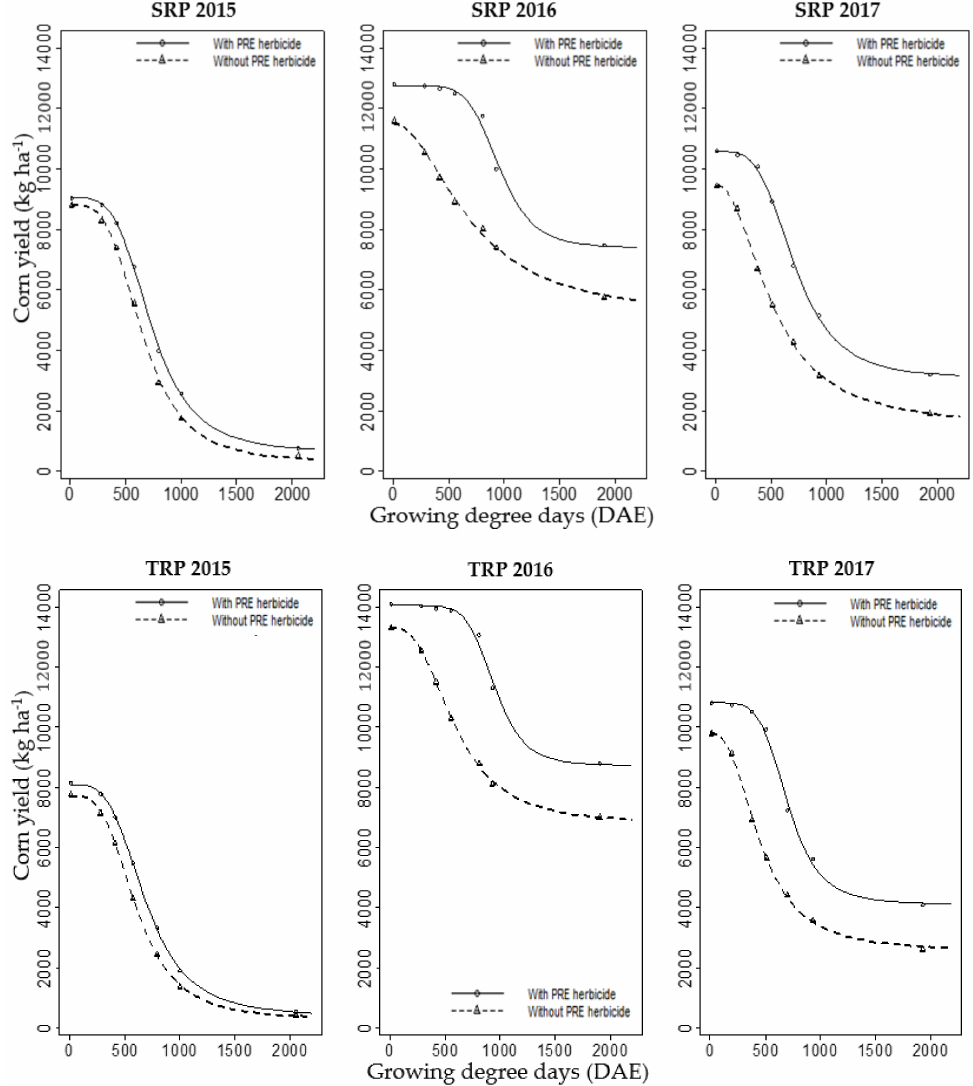
Figure 2. Crop yield (kg ha − 1 ) response to increasing duration of weed interference as represented by growing degree days (days after emergence, DAE) in corn grown without pre-emergence (PRE) herbicide and with PRE herbicide treatments in Padina in Serbia